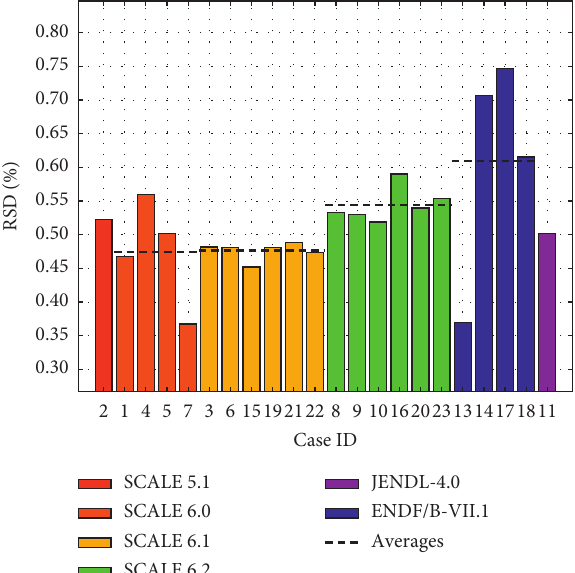
Figure 4: Relative k -inf uncertainty grouped by covariance li- braries utilized for TMI-1 HZP cell physics